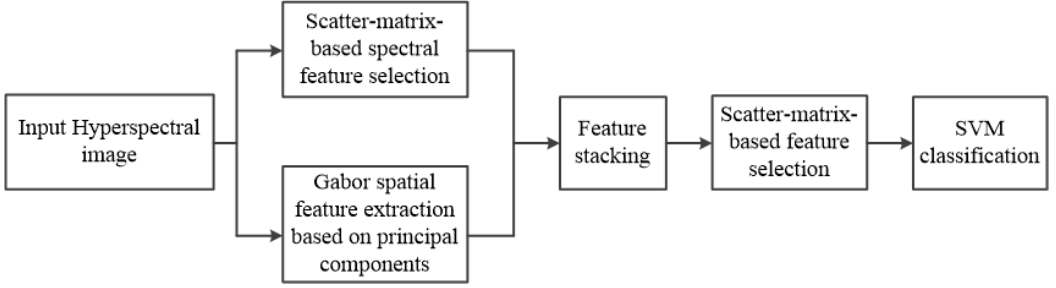
Figure 1. Flowchart of combining spectral features and spatial features for vegetation classification. SVM: support vector machine